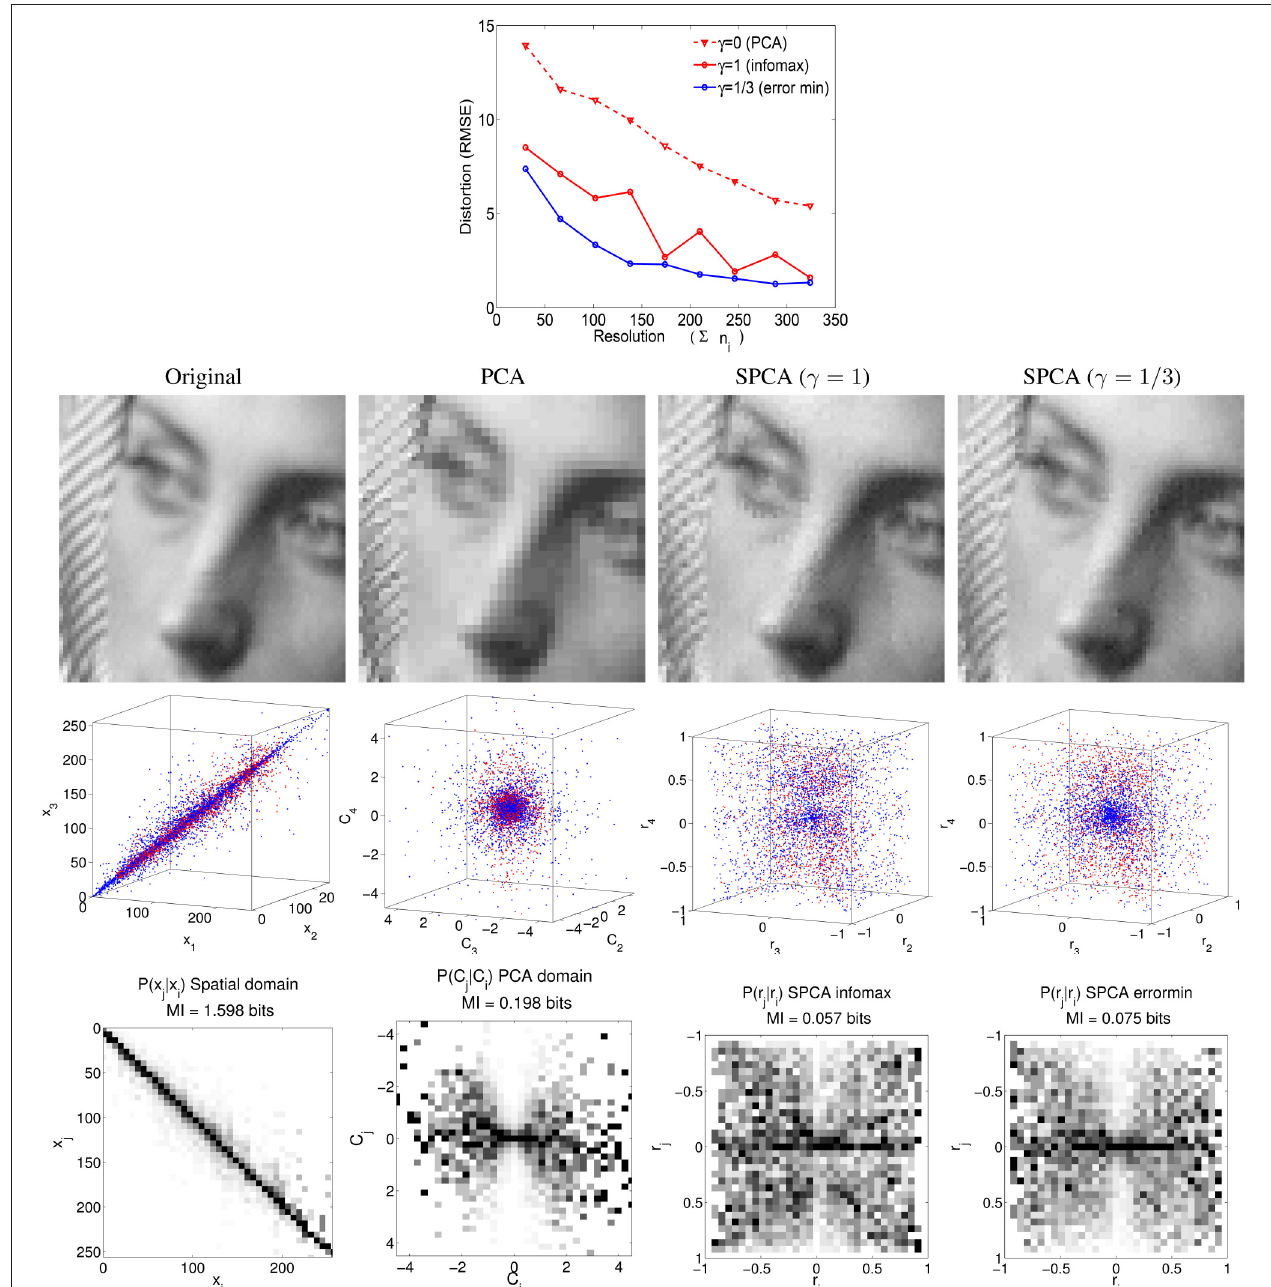
FIGURE 12 | Texture coding using conventional decorrelation (PCA) vs. infomax and error minimization (through SPCA). Top resolution-distortion plot. Second row reconstructed images using the same total number of bins, i n i = 66 , in different representations. Third row training and test samples (in blue and red) P in different domains. In the spatial domain the values represent luminance. In the PCA domain we showed the AC components and amplitudes were expressed in contrast as in Figures 4 , 7 . Four-dimensional histogram equalizations illustrated by the SCPA solutions are examples of the concept outlined in Figure 11 . Fourth row conditional PDFs and mutual information (MI) independence measures in the considered domains. Dependence between coefficients implies visible structures in the conditional PDFs (bow-ties in the case of frequency coefficients). Note that greater MI values are consistent with visible (correlation or bow-tie) structures in the conditional PDFs.